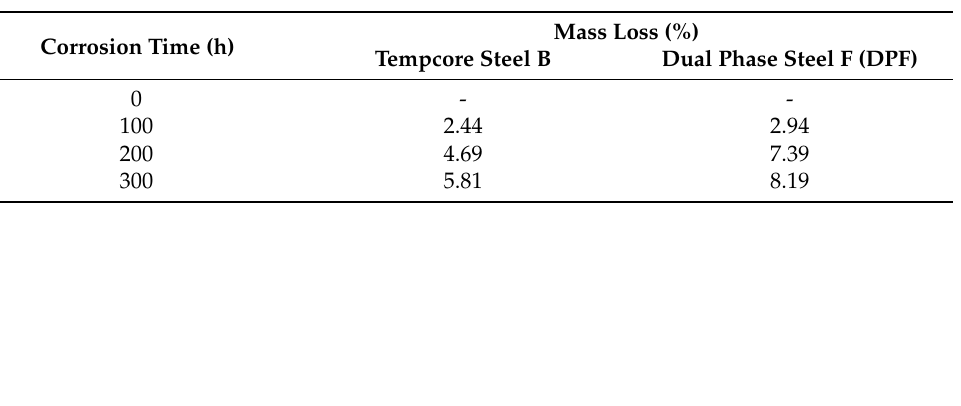
Table 3. Percentage mass loss vs. corrosion time for tensile specimens (long